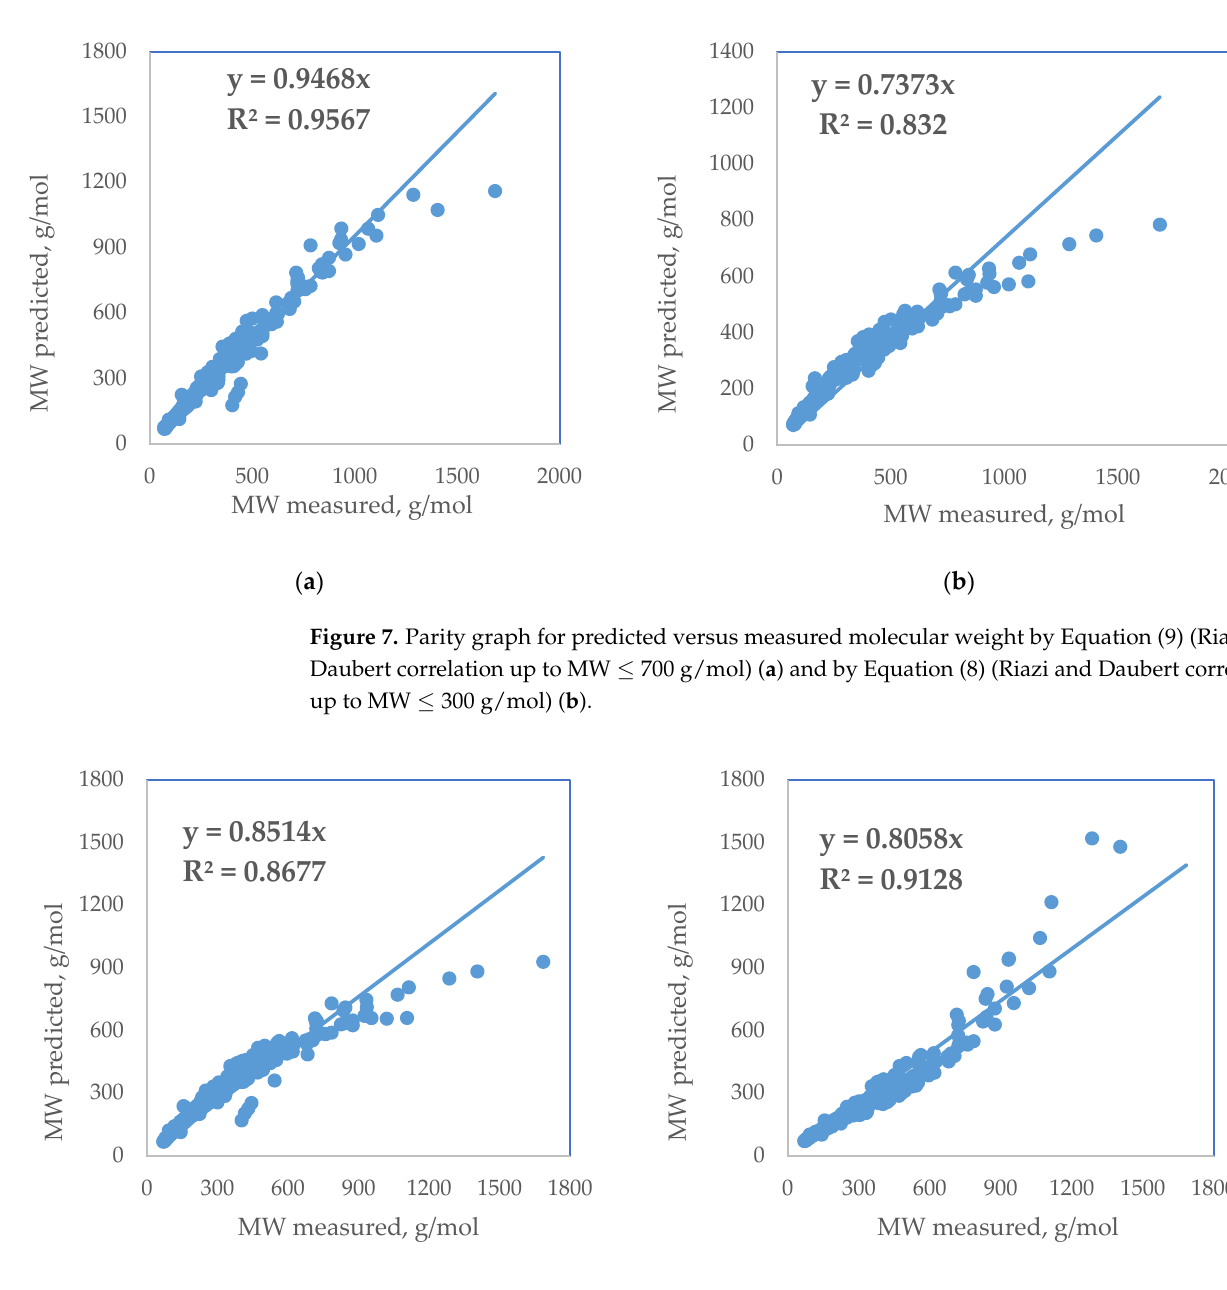
Figure 6. Parity graph for predicted versus measured molecular weight by Equation (7) (Goosens correlation) ( a ) and by Equation (11) (API method, 2011) ( b ).